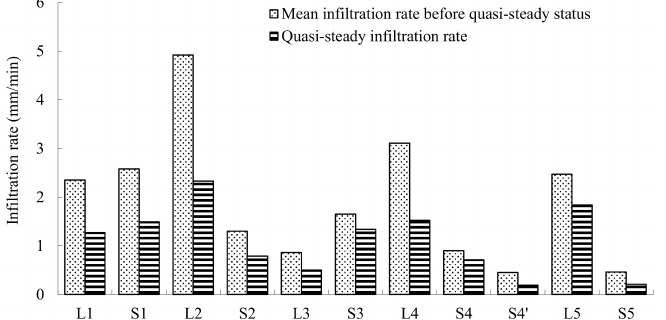
Figure 4. Comparison of the infiltration rates of di ff erent loess / paleosol layers in the Chinese Loess Plateau southern; Note: S 4 (cid:48) is CaCO 3 concretion